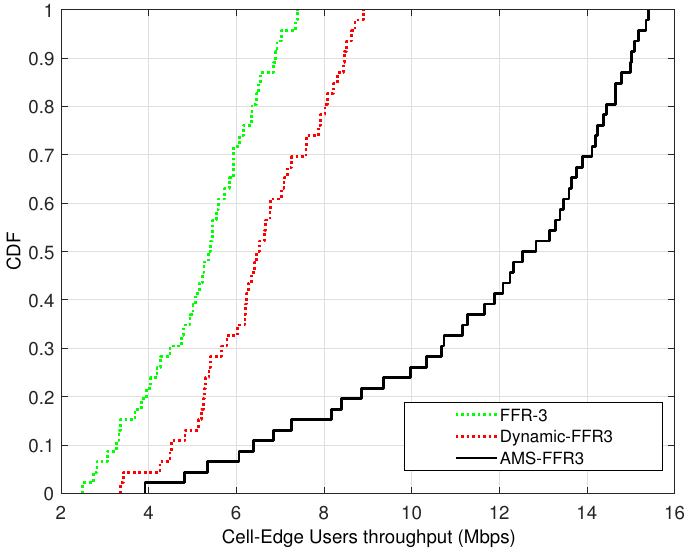
Figure 6. CDF of the cell-edge users’ achievable throughput.